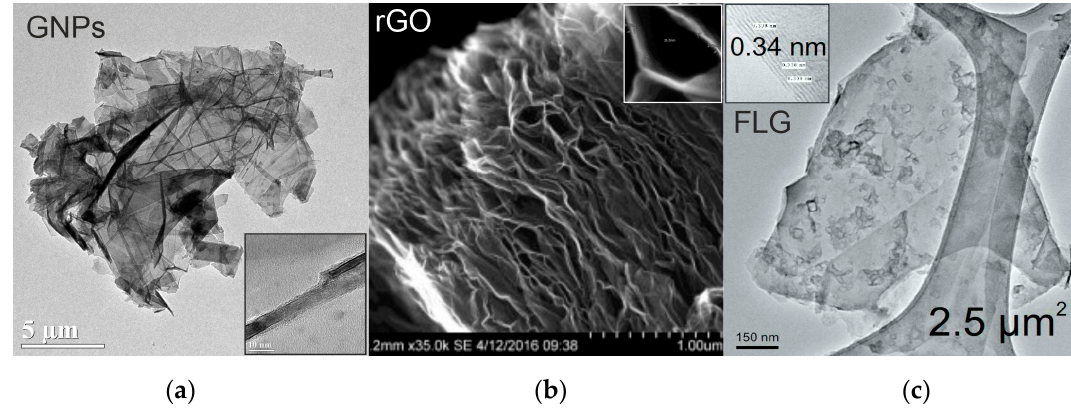
Figure 1. Electronic micrographs of the graphenic nanomaterials used: ( a ) GNPs (graphene nanoplatelets); ( b ) rGO (reduced graphene oxide); ( c ) FLG (pristine few-layer graphene). Enlargements inserted in the corresponding pictures show the number of layers and the distance between crystalline